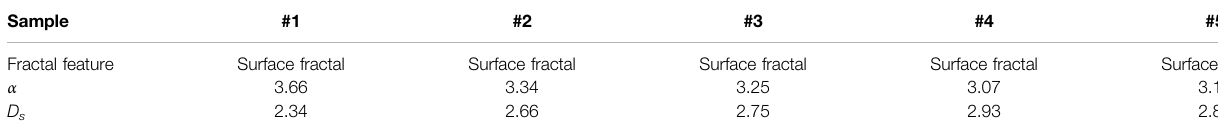
TABLE 2 | Results of the pore structure properties of coal samples based on SAXS.